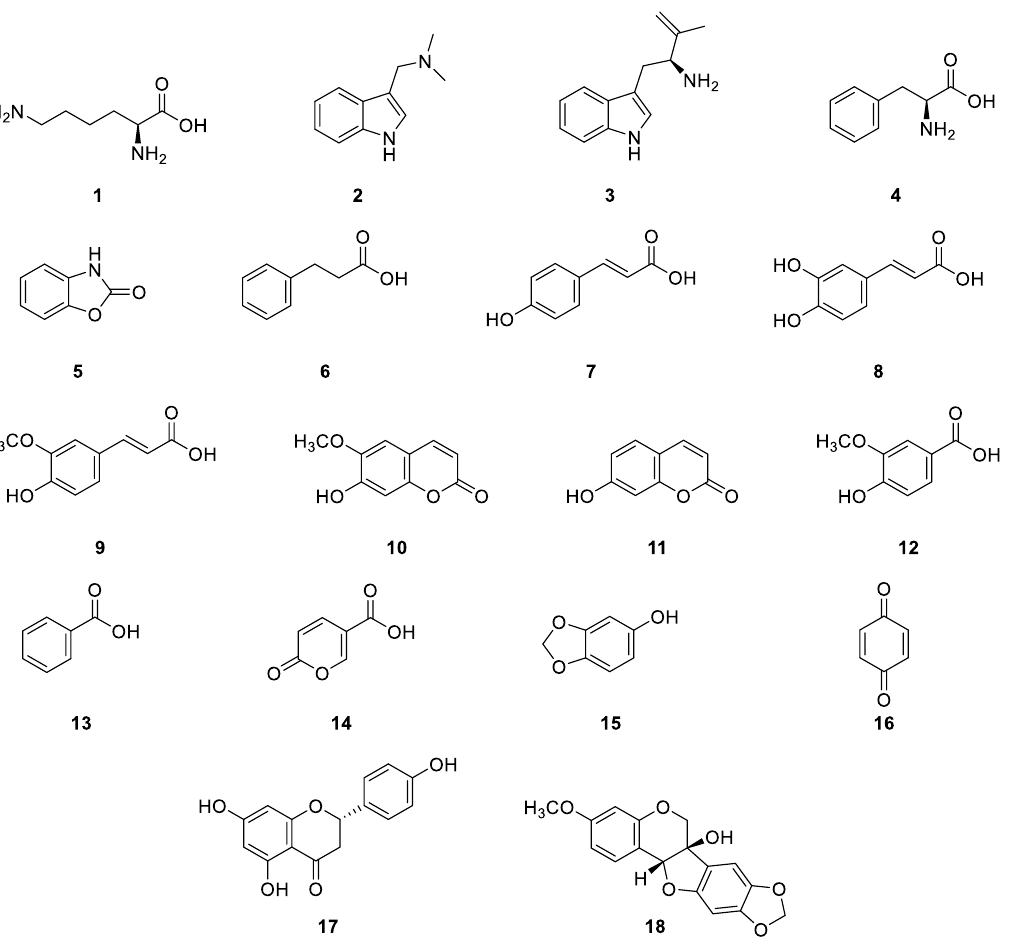
Figure 1. Chemical structures of the compounds studied in the first screening: L -lysine ( 1 ), gramine ( 2 ), L -tryptophan ( 3 ), L -phenilalanine ( 4 ), 2-benzoxazolinone ( 5 ), hydrocinnamic acid ( 6 ), p -coumaric acid ( 7 ), caffeic acid ( 8 ), ferulic acid ( 9 ), scopoletin ( 10 ), umbelliferone ( 11 ), vanillic acid ( 12 ), benzoic acid ( 13 ), coumalic acid ( 14 ), sesamol ( 15 ), 1,4-benzoquinone ( 16 ), naringenin ( 17 ) and pisatin ( 18 ).